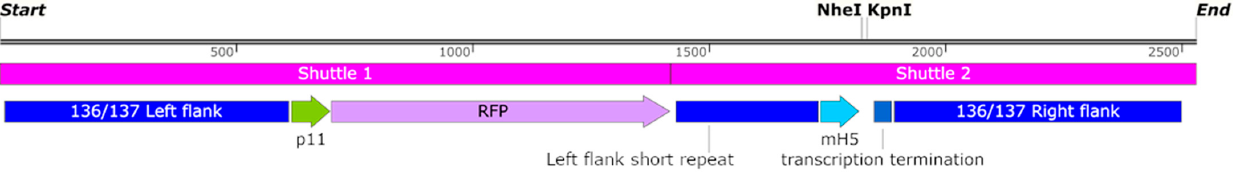
Figure A1. Map of the functional part of the vector pShuttle-136/137. Blocks labeled Shuttle 1 and Shuttle 2 show the division of the design into fragments, necessary for the synthesis of the sequence. p11 and mH5 promoters from the vaccinia virus drive the expression of RFP and GOI, respectively. The vaccinia virus termination signal (labeled as Term on the scheme) was used to stop the transcription of RFP gene and GOI. The DNA sequence of GOI can be inserted using restriction sites NheI/KpnI.